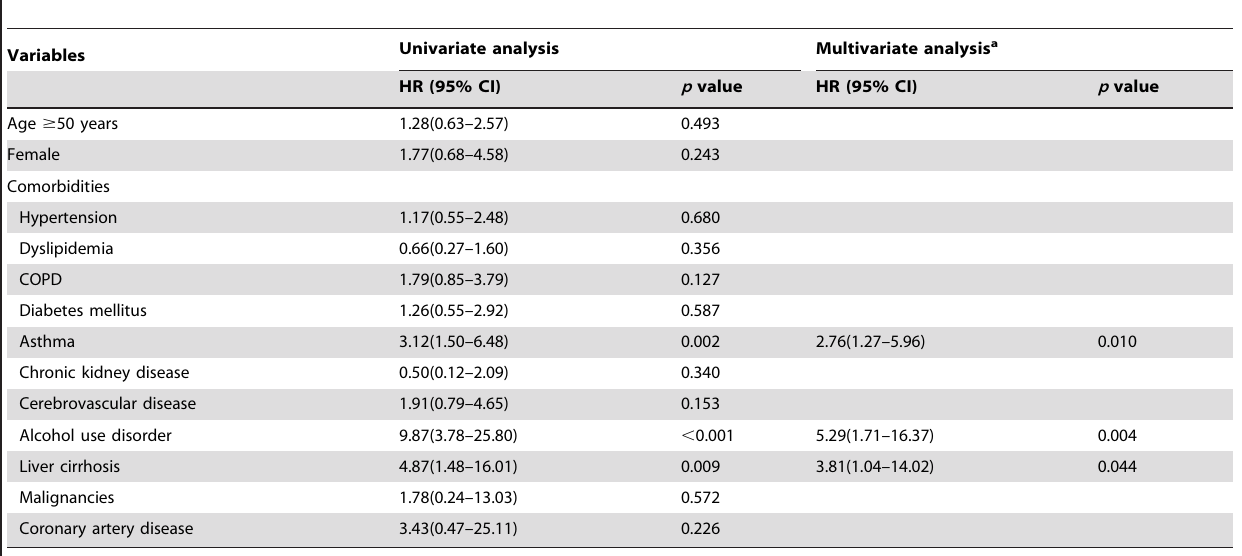
Table 3. Risk factors for bipolar disorder among patients with rheumatoid